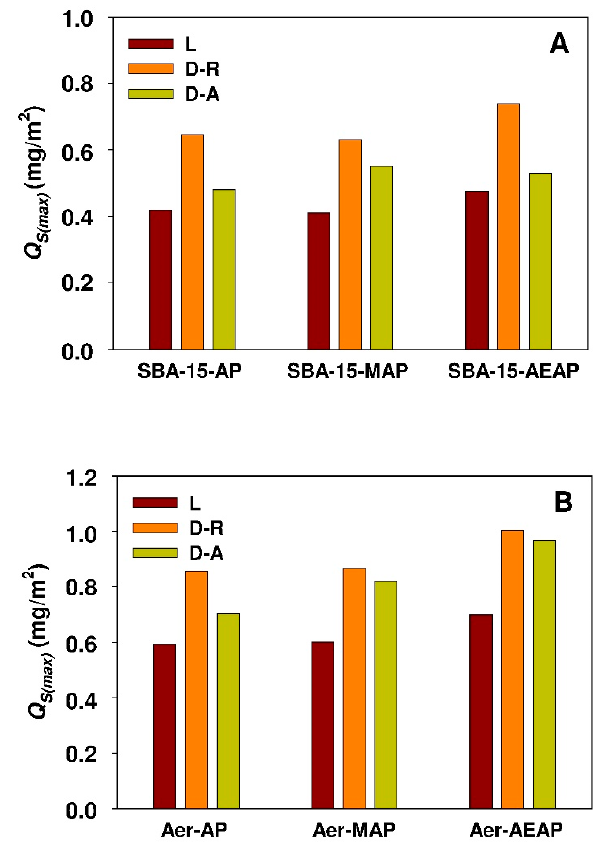
Figure 15. Surface area-normalized maximum adsorption capacity of ( A ) modified SBA-15 silicas and ( B ) modified Aerosil ® siliacas towards 18 β -glycyrrhetinic acid. The parameter calculated from maximum adsorption capacity estimated from nonlinear fitting analysis. Isotherms: D-A, Dubinin-Astakhov; D-R, Dubinin-Radushkevich; L, Langmuir.